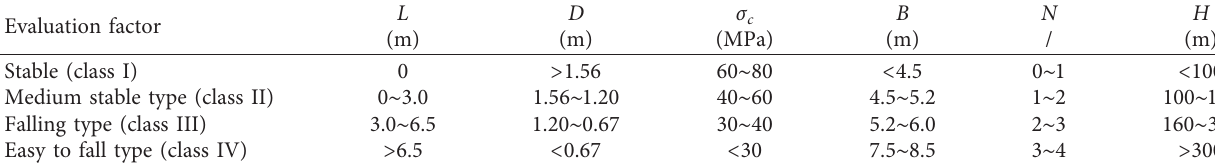
Table 2: The roof stability type and the original data of each index evaluating gene.